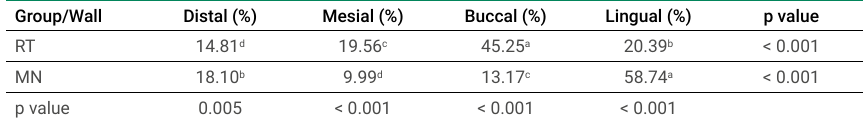
Table 1. Frequency distribution (%) of remaining filling material presence after retreatment in the root canal walls according to the experimental groups Group/Wall Distal (%)